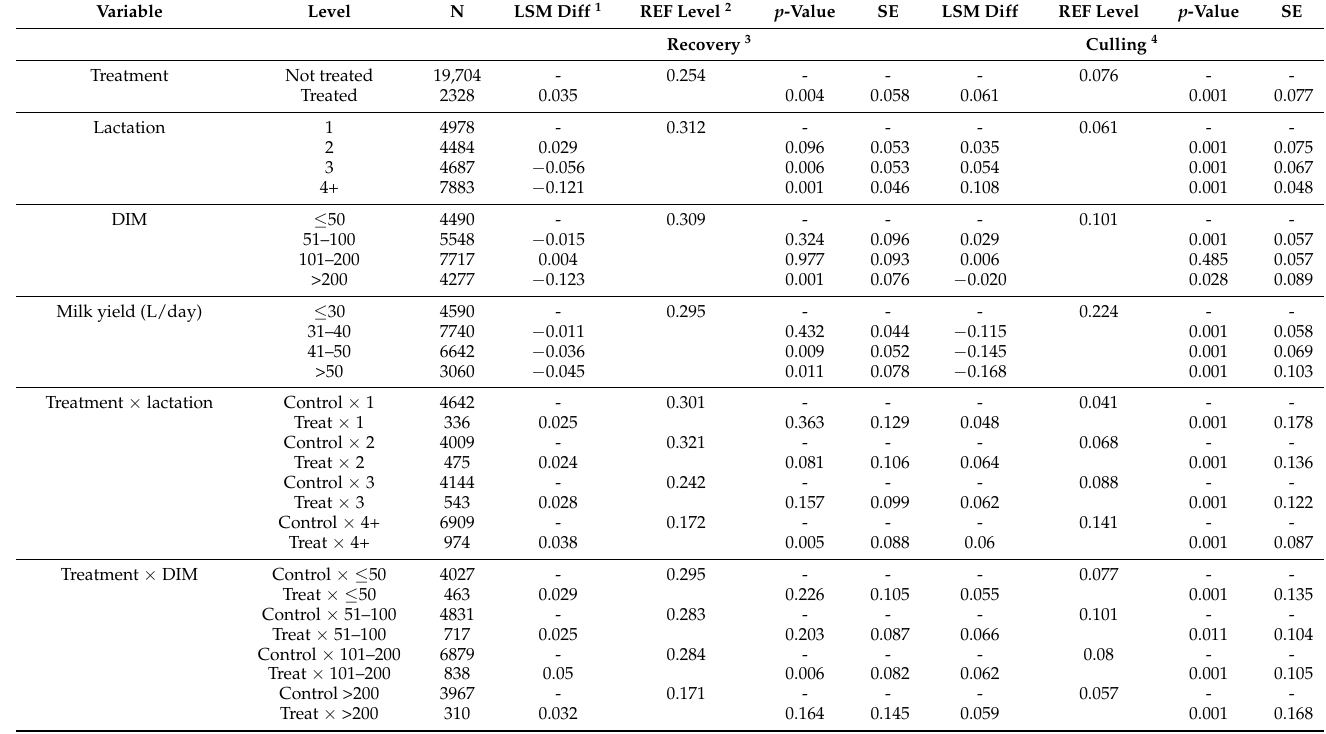
Table 4. Association between treatment, lactation number, days in milk (DIM) and milk yield on day of somatic cell count (SCC) elevation ≥ 1000 × 10 3 (CL5) and spontaneous recovery, recovery after antibiotic treatment (recovery set to <250 × 10 3 cells/mL), and culling percentage (90 days) due to mastitis